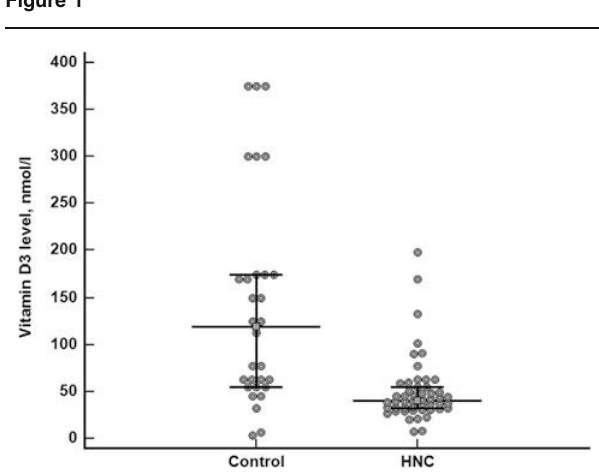
Phosphate level in cases with HNC and controls. Circular markers represent individual observations. Squared marker with traversing horizontal line represents the median (second quartile). Error bars represent the 25th and 75th percentiles (first and third quartiles, respectively). HNC, head and neck